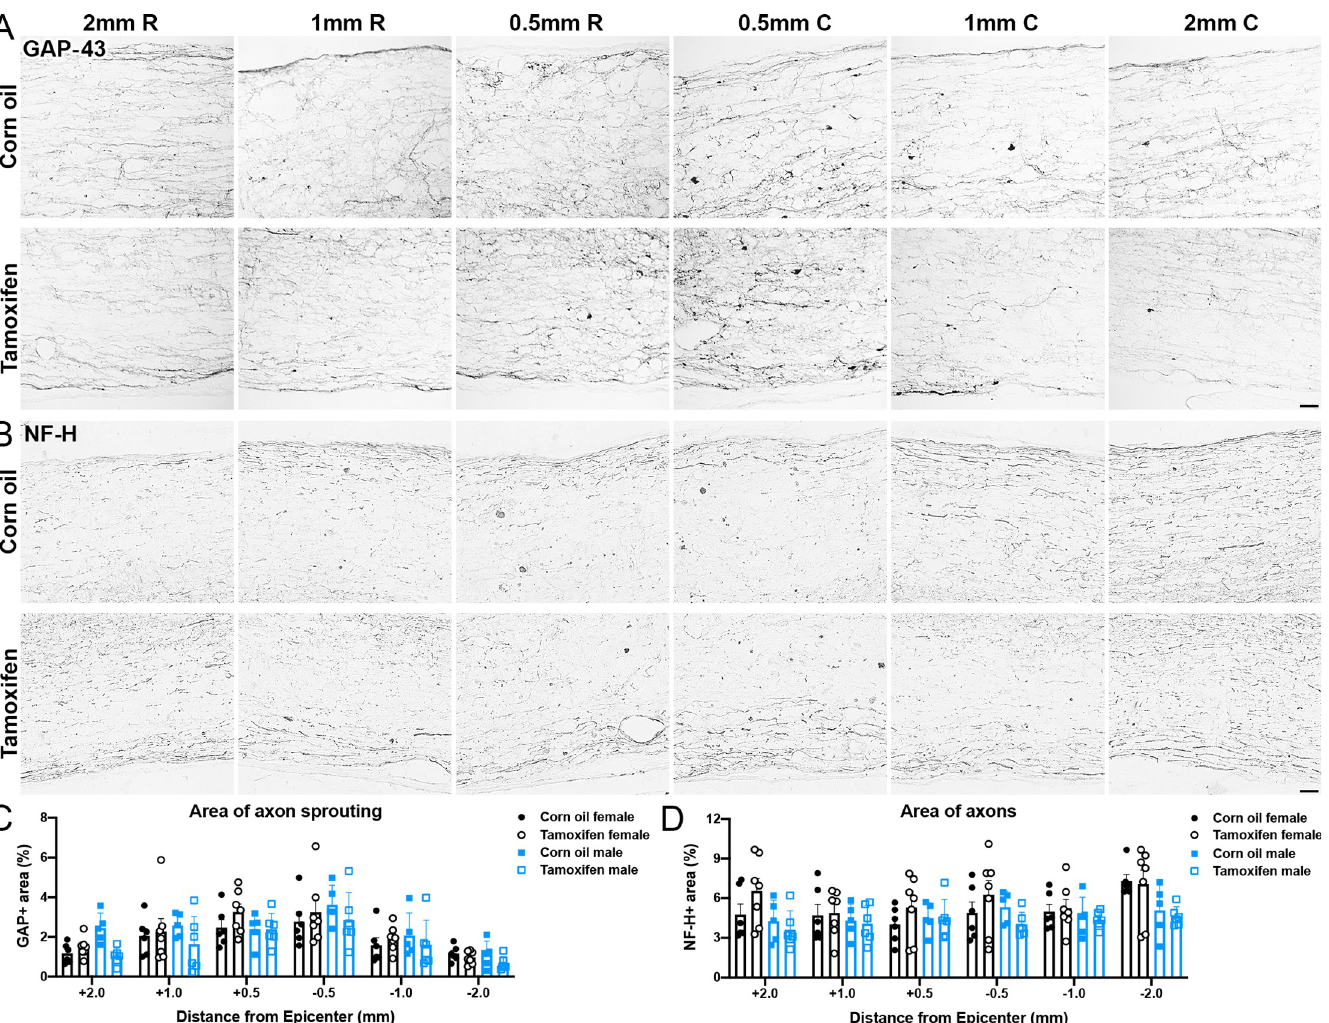
Fig 5. Delayed tamoxifen treatment does not alter total axon area after SCI. (A-B) Representative images of longitudinal spinal cord sections immunolabeled for (A) GAP-43 and (B) neurofilament-heavy (NF-H). Scale bar = 20 μ m. (C-D) Percent area of (C) GAP-43 and (D) NF-H+ axons in the lateral white matter 2 mm, 1 mm, and 0.5 mm rostral and caudal to the lesion epicenter. No significant differences are reported between groups. Data presented as mean + SEM. Two-way repeated measures ANOVA with Sˇı´da´k post hoc test; corn oil female n = 6; tamoxifen female n = 7; corn oil male n = 5; tamoxifen male n =